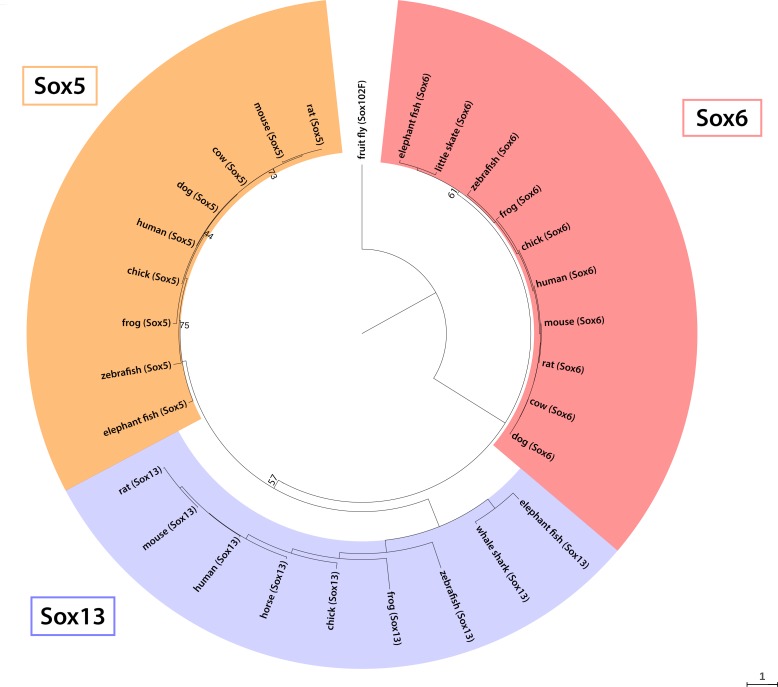
Phylogenetic analysis of the vertebrate SoxD family.Phylogenetic analysis of amino acid sequences of selected vertebrate SoxD family members resolves three clades (Sox5, Sox6 and Sox13), and confirms orthology of our newly reported little skate Sox6 sequence (GenBank MT254562). We also report a new sequence fragment for little skate Sox5 (GenBank MT254561), which falls within the predicted 3’ UTR, and so was not included in this analysis.